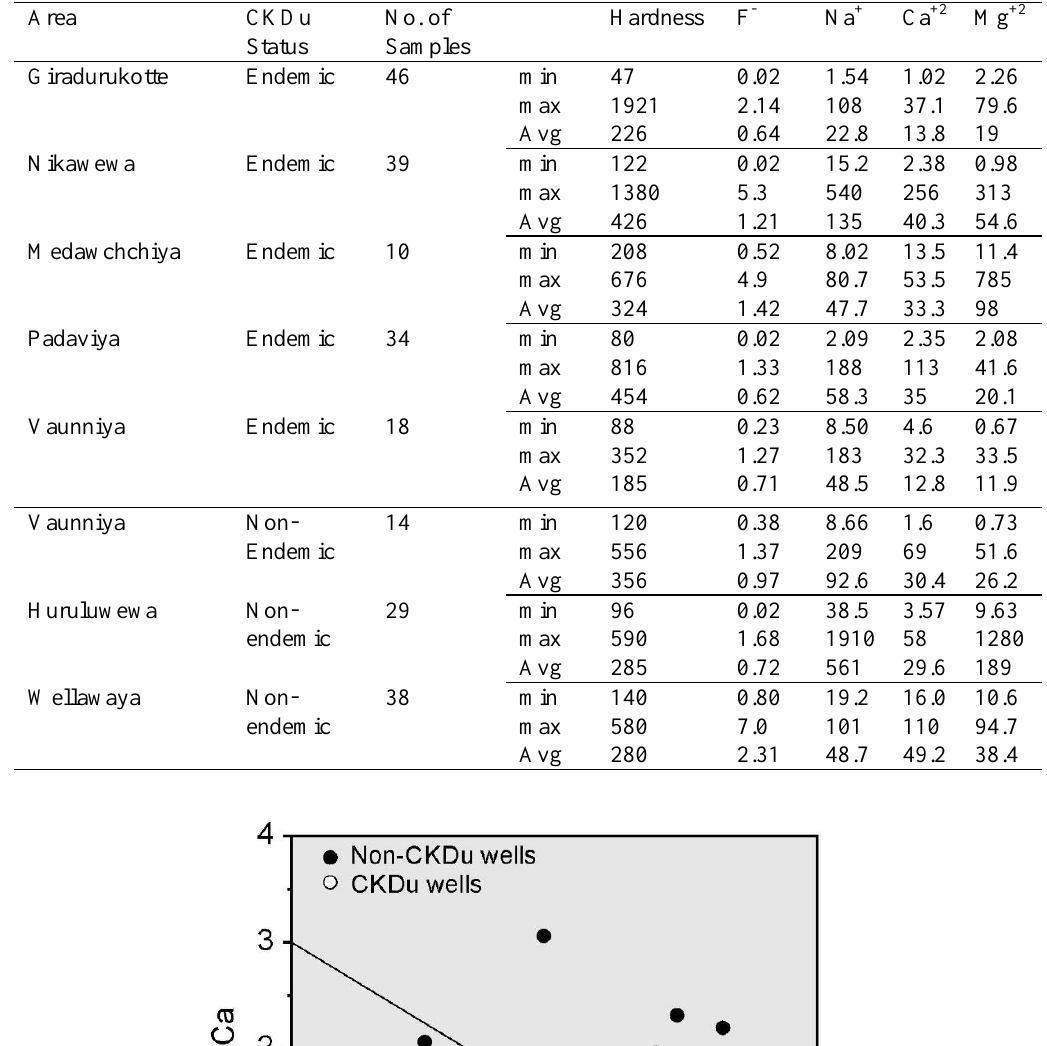
Table 1: Summary statistics of some chemical parameters in drinking water wells from CKDu and Non-CKDu regions of Sri Lanka.